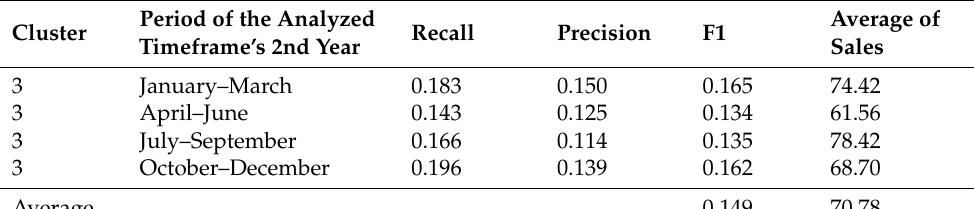
Table 11. Application outputs for the third cluster customers of the proposed